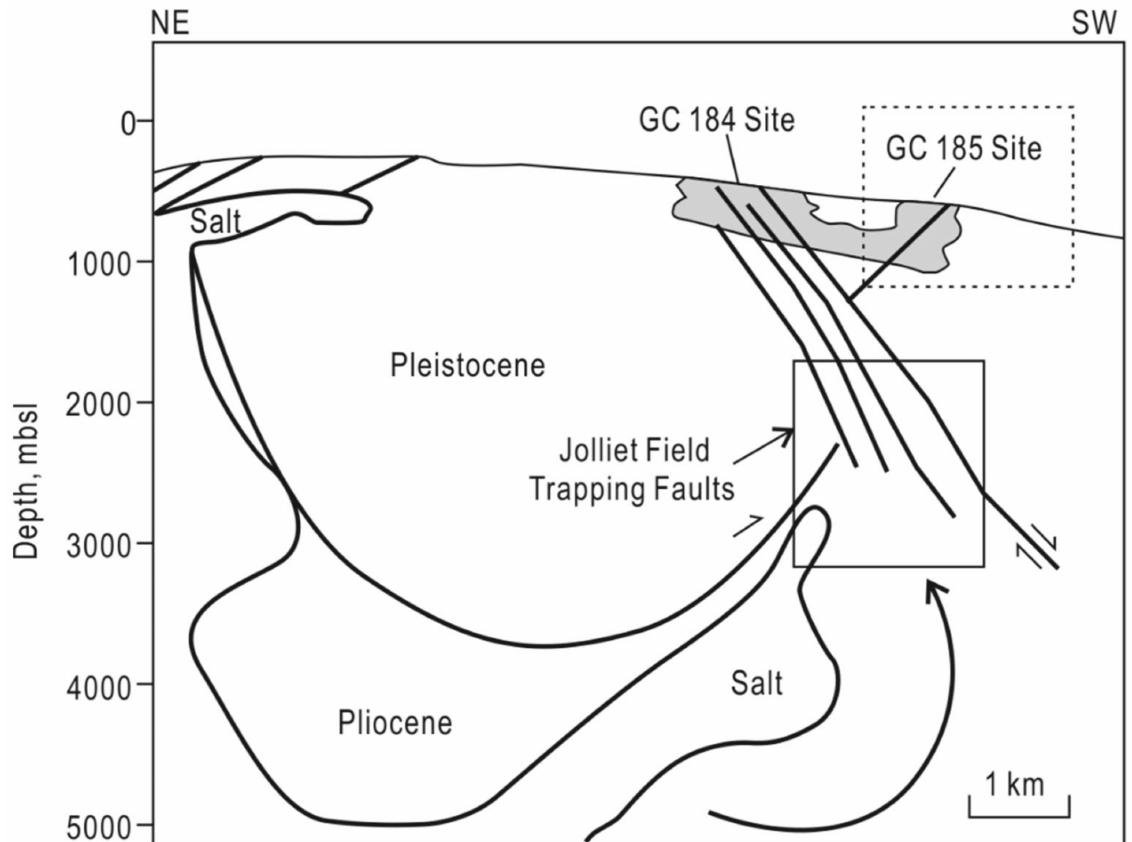
Figure 14. Diagram showing the diapir-fault-controlled shallow hydrate system at Bush Hill on the upper slope of the northern GoM. The normal faults at the top of the salt diapir constitute the trap at Jolliet Field. Thermogenic gas migrates along the antithetic fault that connects the normal faults toward the seafloor (GC185 site) (cited from [77]). Note: The dashed box represents the location of Figure